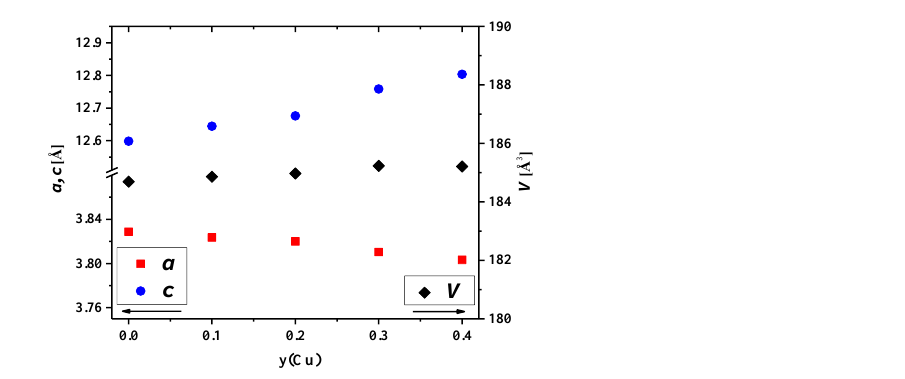
Figure 2. Dependencies of the unit cell parameters and volumes for the La 1.7 Ca 0.3 Ni 1 − y Cu y O 4+ δ series on the Cu content.